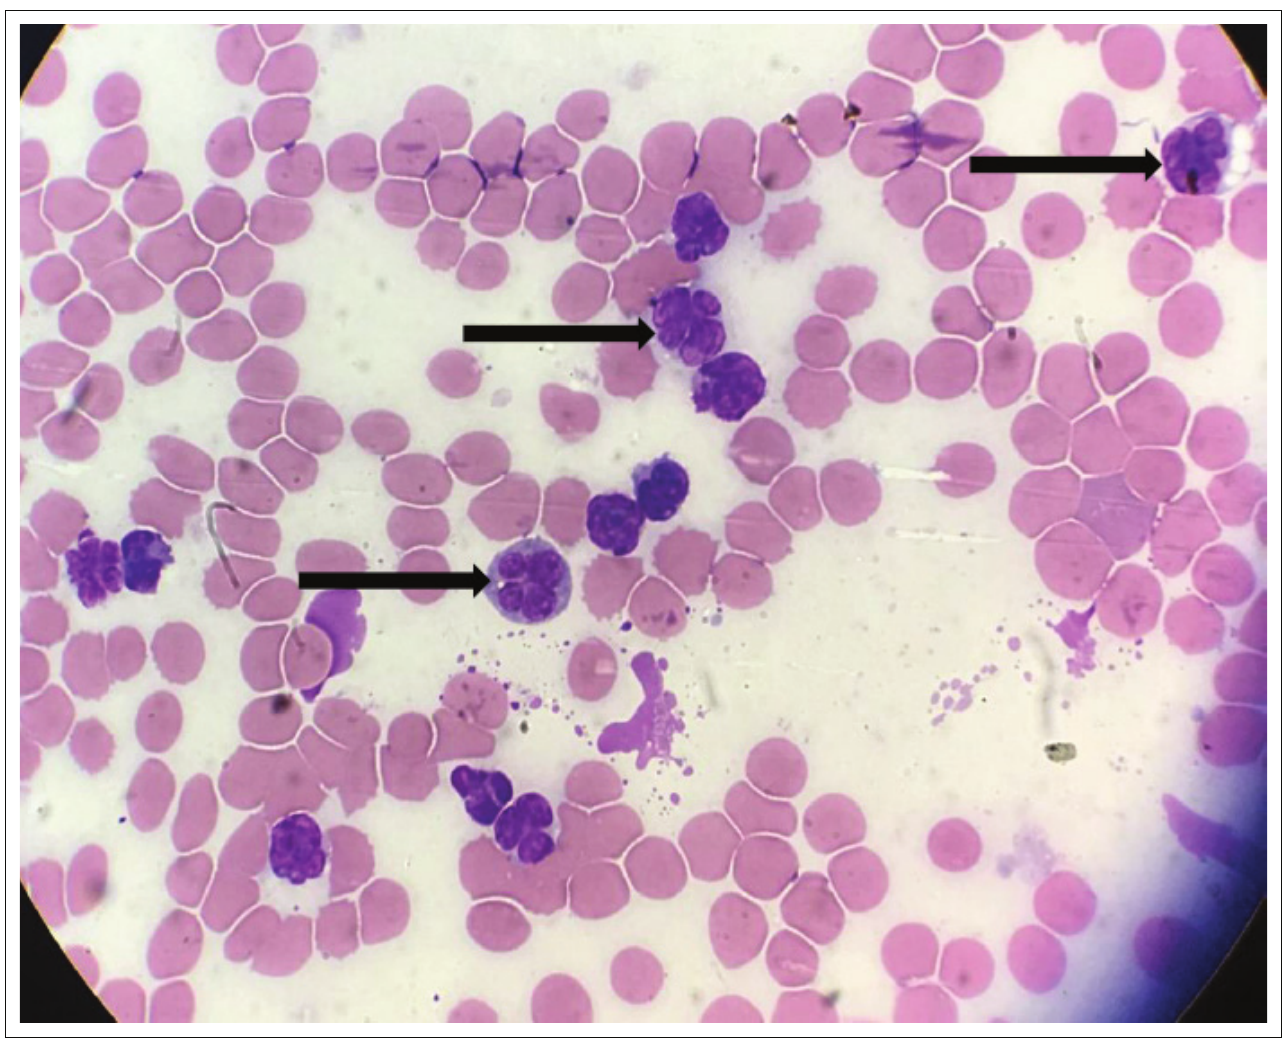
FIGURE 1: Flower cells on peripheral blood